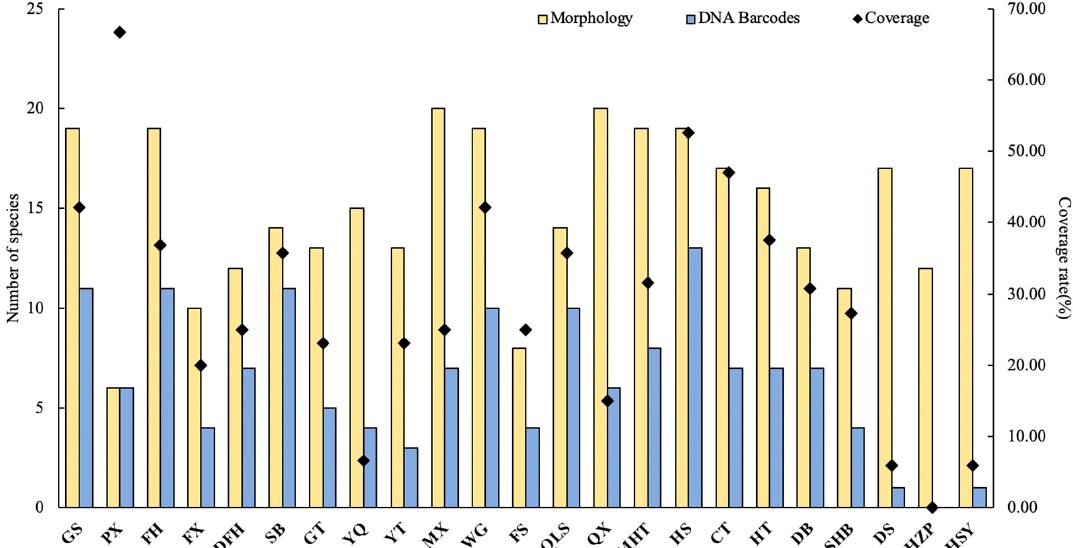
Figure 3. The number of rotifer species identified morphologically in the quantitative samples and number of species identified with COI barcodes from in the 23 reservoirs, and the coverage rate (%) of COI barcodes in the 23 investigated reservoirs (The coverage of DNA barcodes is the percentage of the number of species successfully obtained COI to the number of species identified morphologically in the quantitative sample.). Table 2. Intraspecific genetic distance (K2P) of 24 rotifer